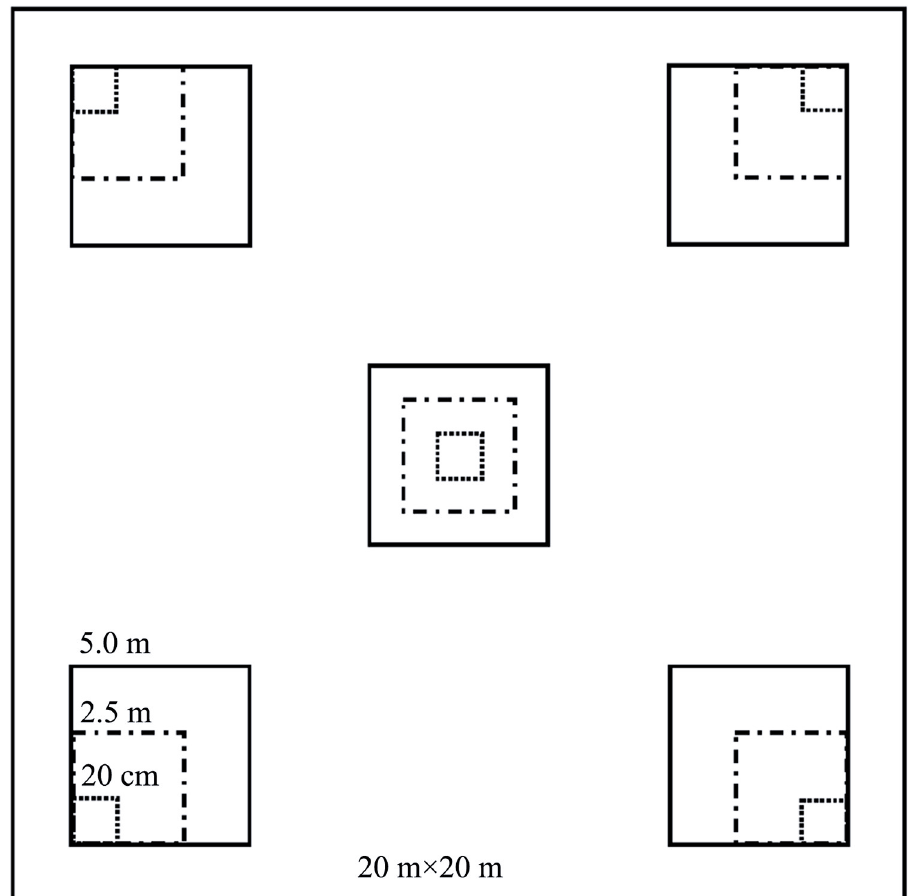
Fig 2. Experimental plot configuration.